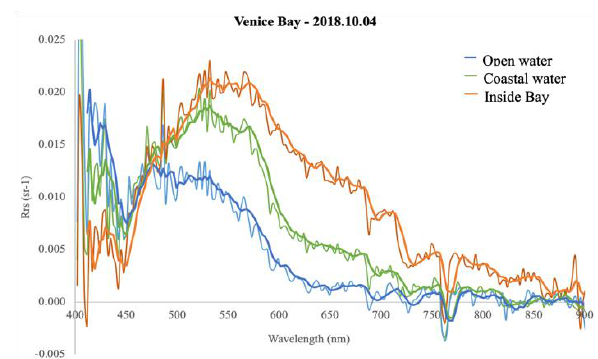
Figure 4 . Rrs spectrum for the three stations plotted in Figure 3. Solid lines represent spectra smoothed by a 5-point moving